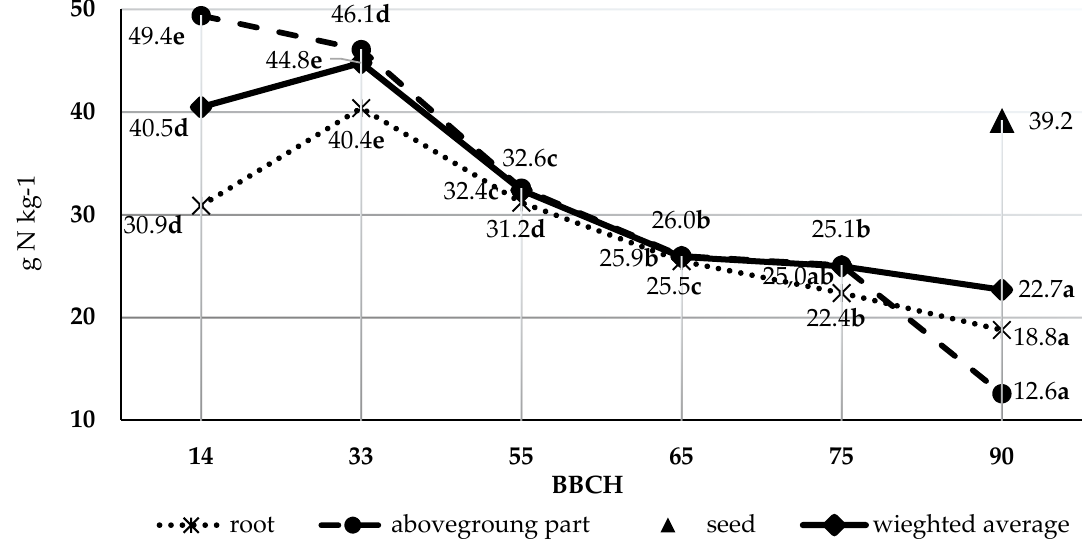
Figure 1. Nitrogen content in dry weight of pea in following growth stages, g N · kg − 1 , (meanly from three replications, cultivars, and years), a, b, c, … —averages for the same separated part of the plant with different letters are significantly different, p < 0.05.